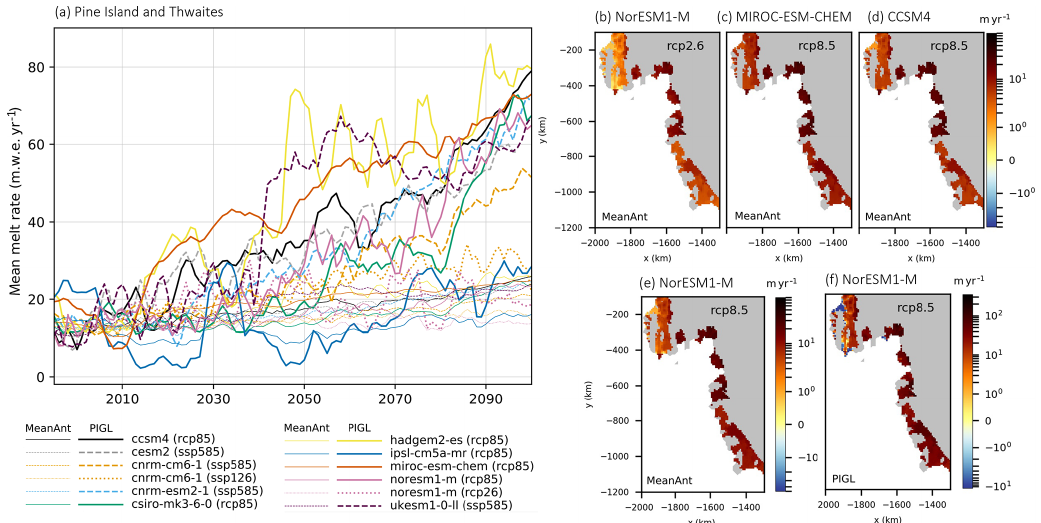
Figure 7. Mean cavity basal melt rates (mw.e.yr − 1 ) under the RCP2.6, RCP8.5, SSP1-2.6, and SSP5-8.5 scenarios over the 21st century for MeanAnt and PIGL calibrations and nonlocal parameterizations in the Amundsen Sea sector. (a) Time series for Pine Island and Thwaites ice shelves obtained with MeanAnt (thin lines) and PIGL (thick lines) calibrations (adapted from Jourdain et al., 2020). Spatial patterns of mean sub-shelf basal melt rate from 2081 to 2100 for the Tier 1 models assuming MeanAnt calibration for (b) NorESM1-M under RCP2.6, (c) MIROC-ESM-CHEM under RCP8.5, (d) CCSM4 under RCP8.5, and (e) NorESM1-M under RCP8.5 and PIGL calibration for (f) NorESM1-M under RCP8.5. The projections from the MeanAnt and PIGL calibrations assume that the ice shelf cavities have not evolved and are set to the present day.